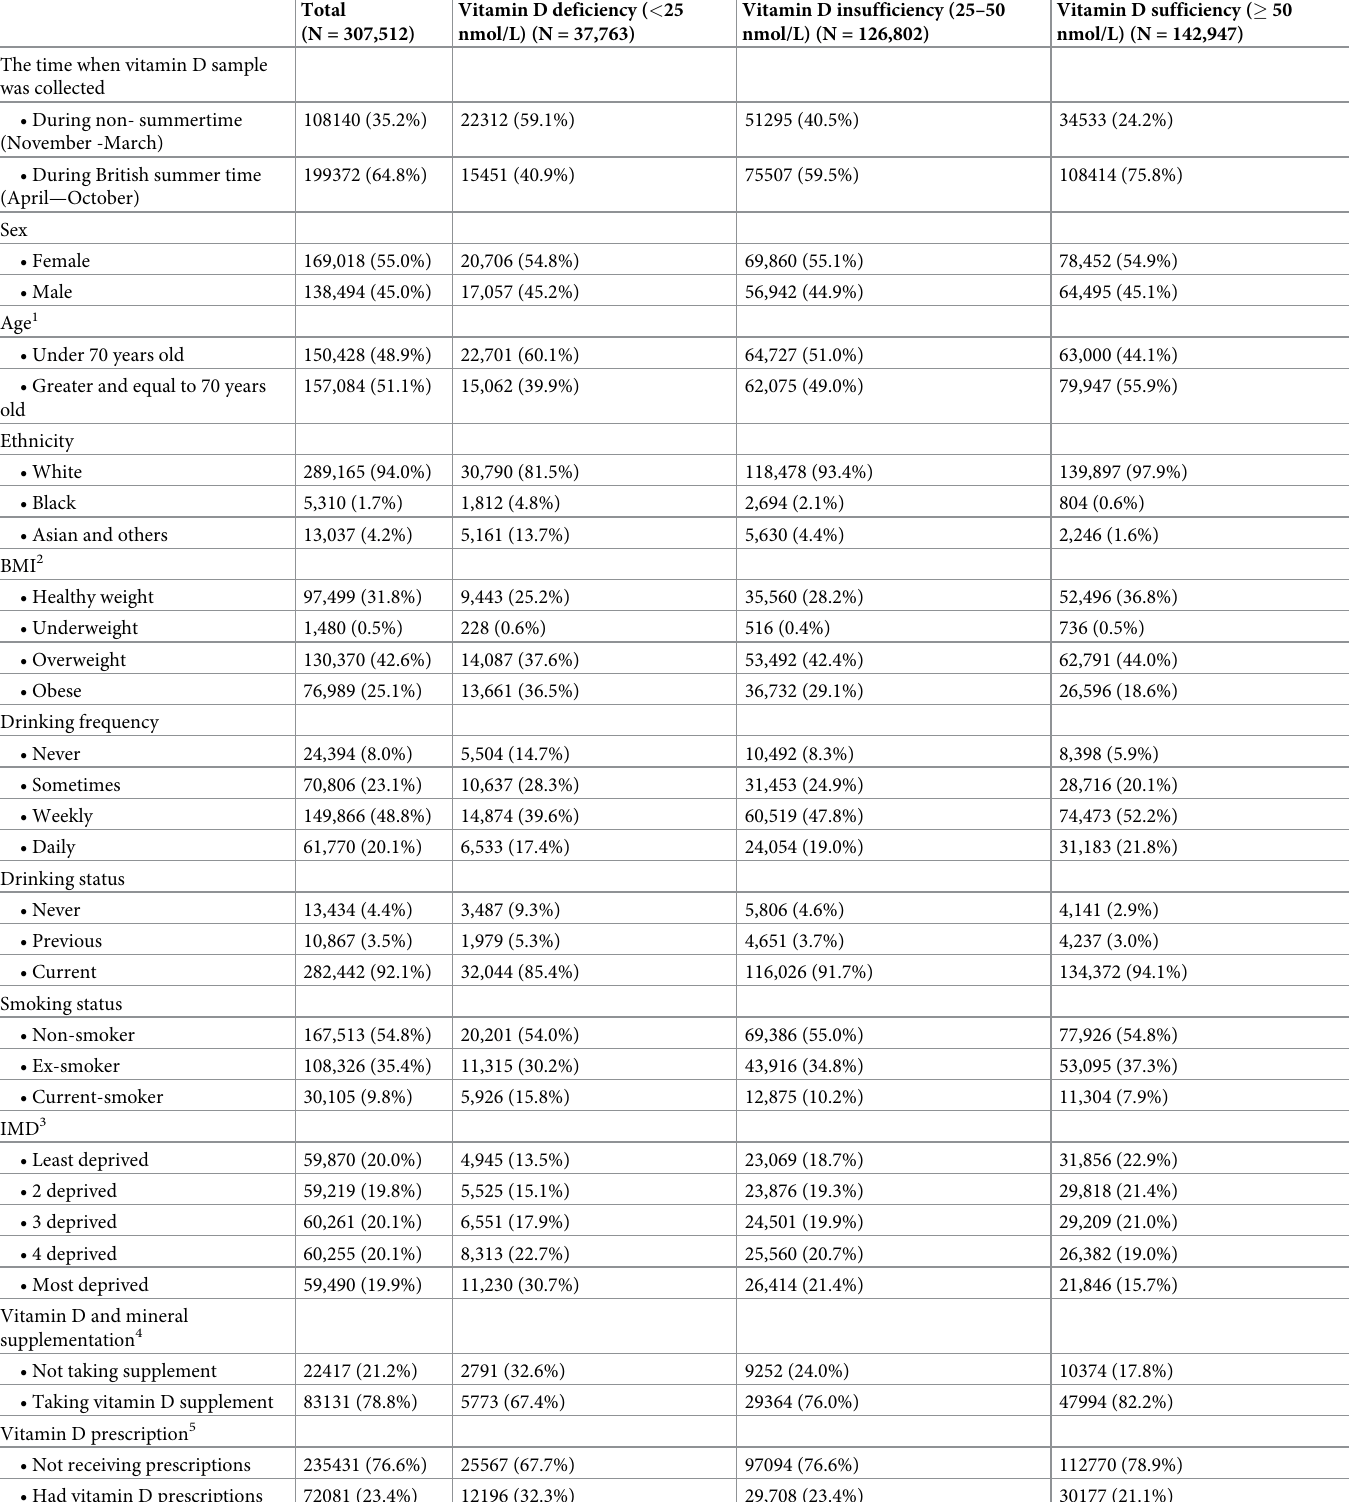
Table 2. The distribution of demographic characteristics by vitamin D